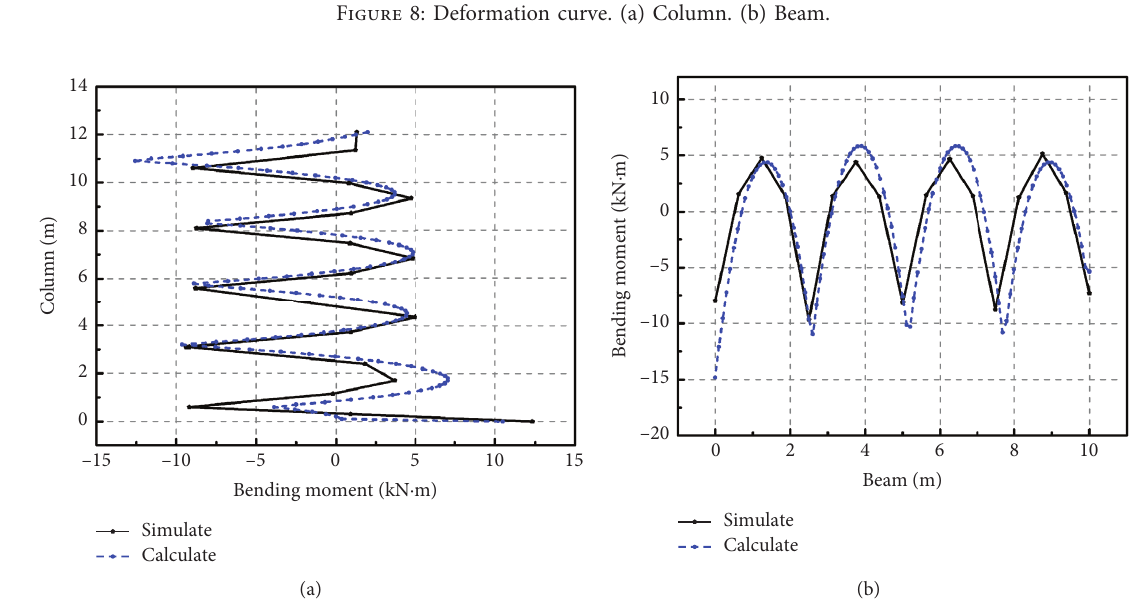
Figure 9: Bending moment curve. (a) Column. (b)